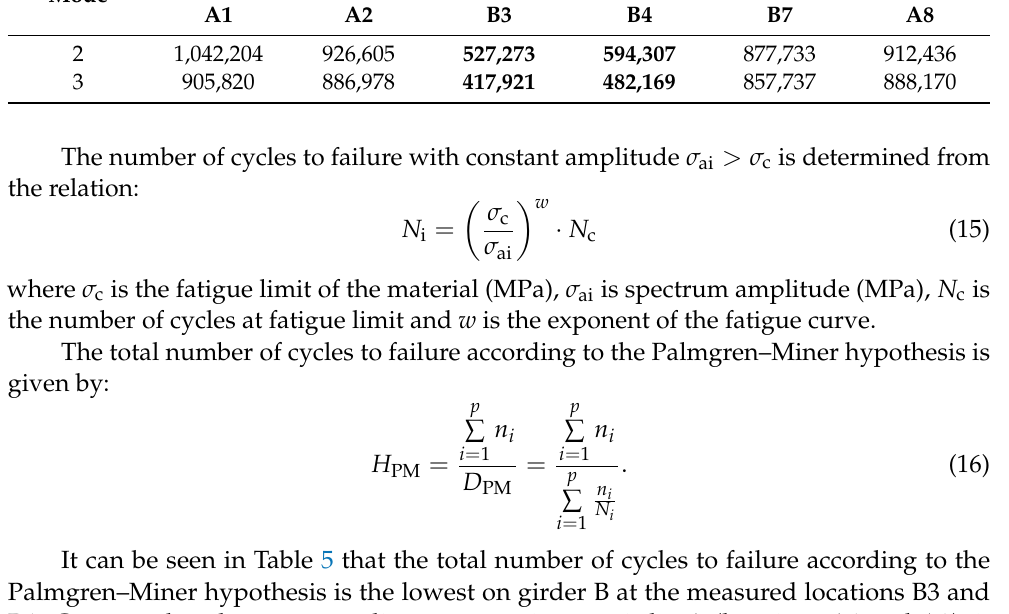
Table 5. Number of cycles to failure according to the Palmgren–Miner hypothesis. Number of Cycles to Failure H PM at Strain Gauge Mode